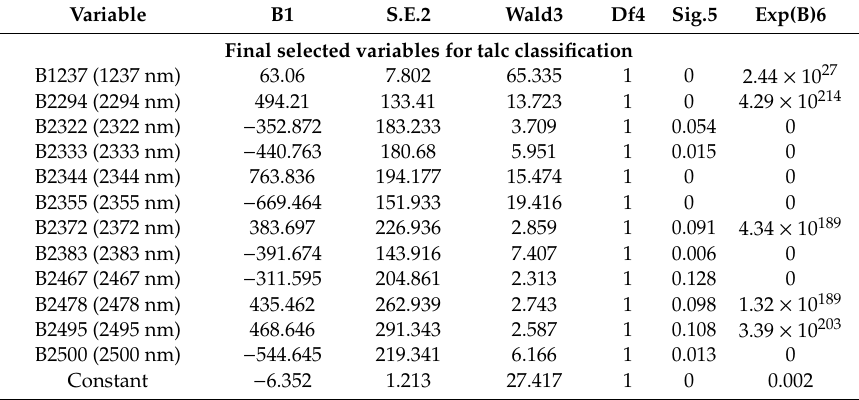
Correct Percentage